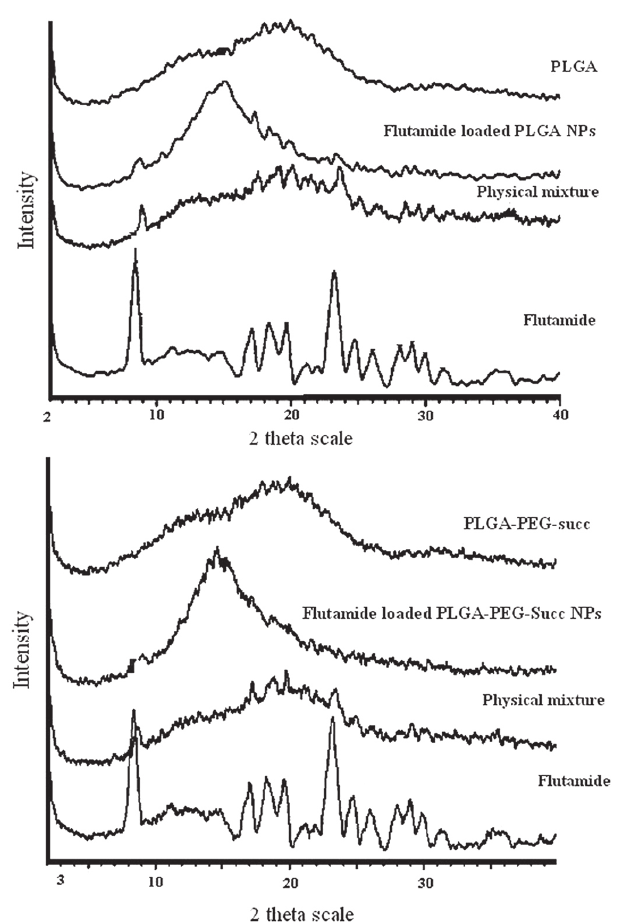
FIGURE 6 - Powder X‑ray diffraction of intact flutamide powder, physical mixtures, flutamide‑loaded